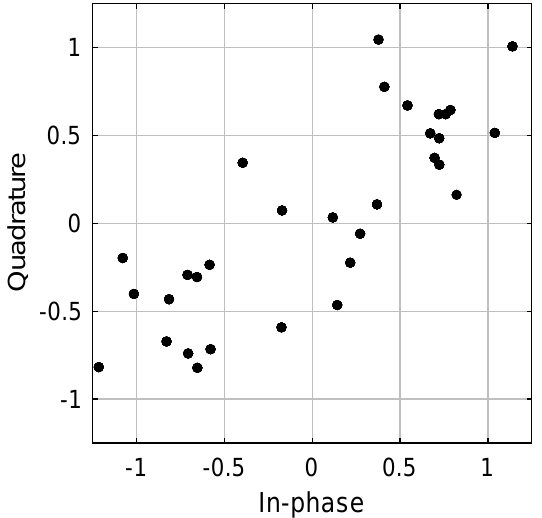
Figure A6. Snapshot of samples of the complex signal r ( nT c ) .